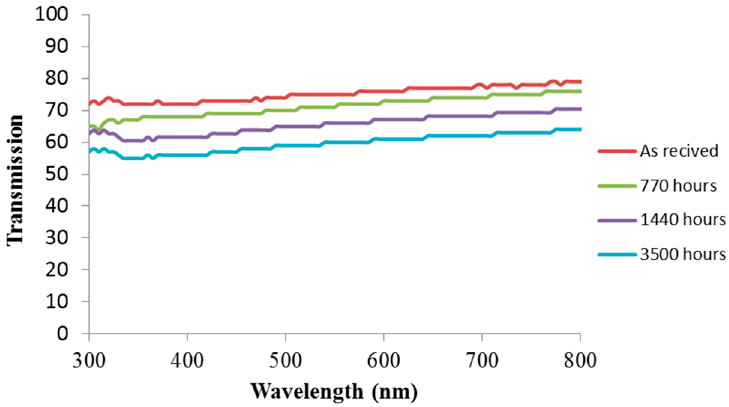
Figure 5. Lambda spectra of 3 mm silicone plates exposed to saline underwater at 100 °C.